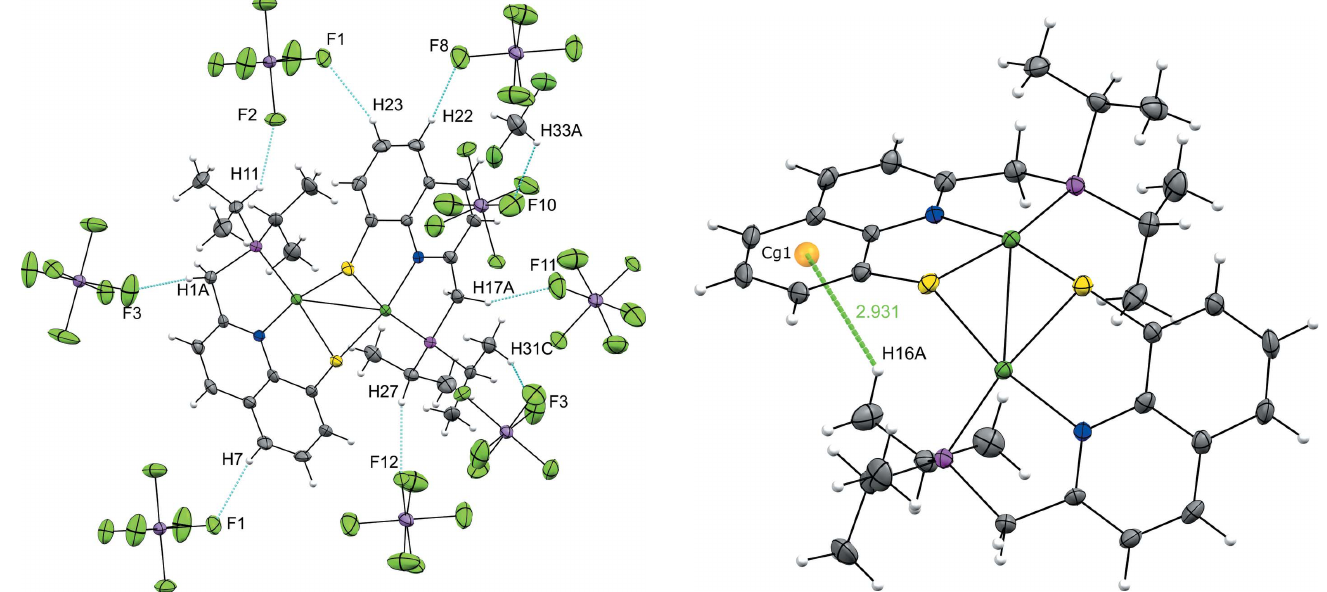
Figure 6 C—H (cid:2)(cid:2)(cid:2) Cg